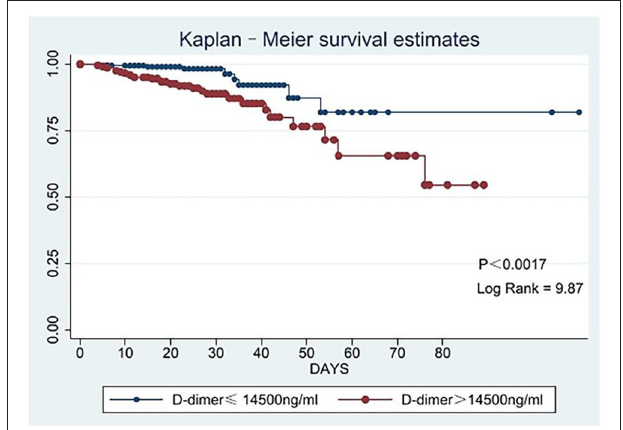
FIGURE 1 | Kaplan-Meier survival curve analyses for the in-hospital mortality according to low and high levels of D-dimer.